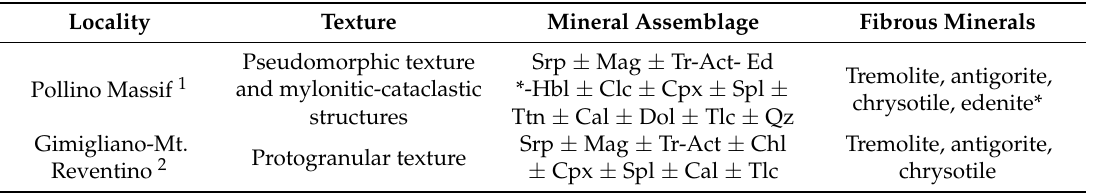
Table 1. Textural features and mineralogical assemblages of serpentinites from the study areas. Abbreviations of mineral names are from Whitney and Evans [51].